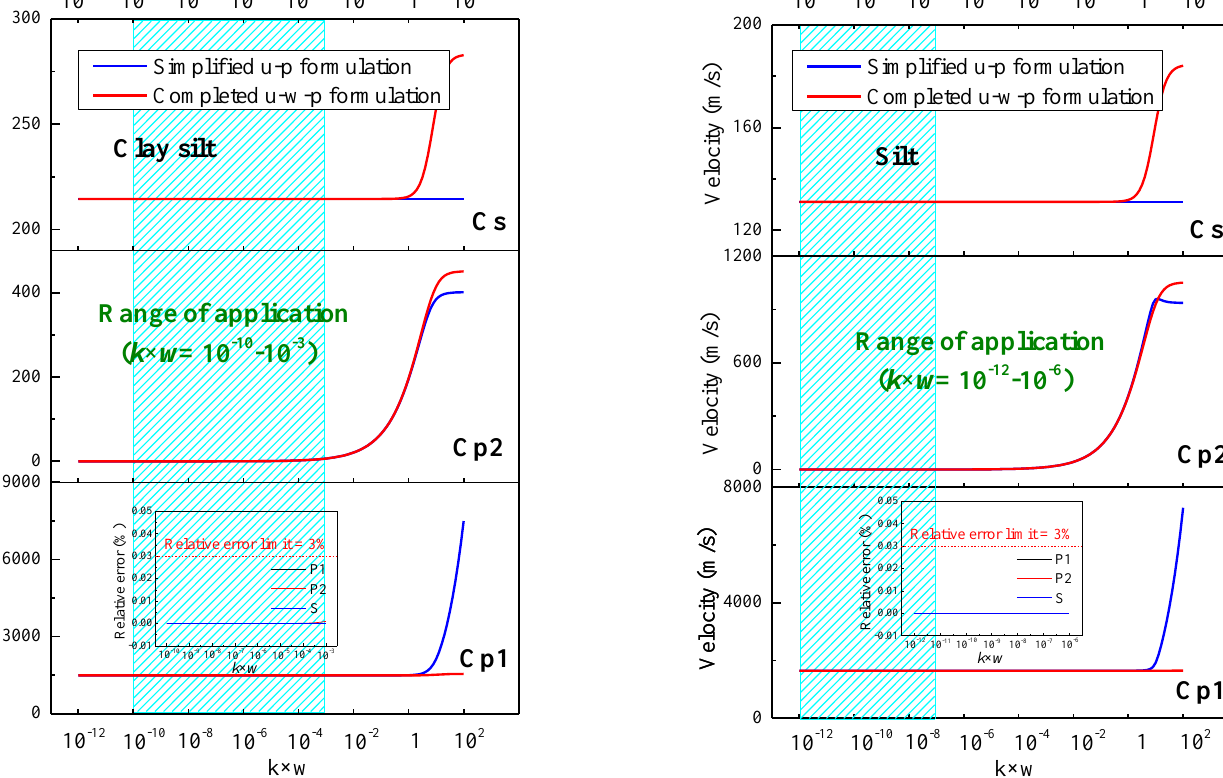
Figure 3. Comparisons of the velocities obtained from u -p and u-w- p formulation in the four saturated soils. In clay silt and silt, value of k · ω is less than 10 − 3 and 10 − 6 , respectively. In this scope, three velocities obtained from u -p formulation are same with them from the u-w- p formulation. The relative errors of the velocities between the two formulations are